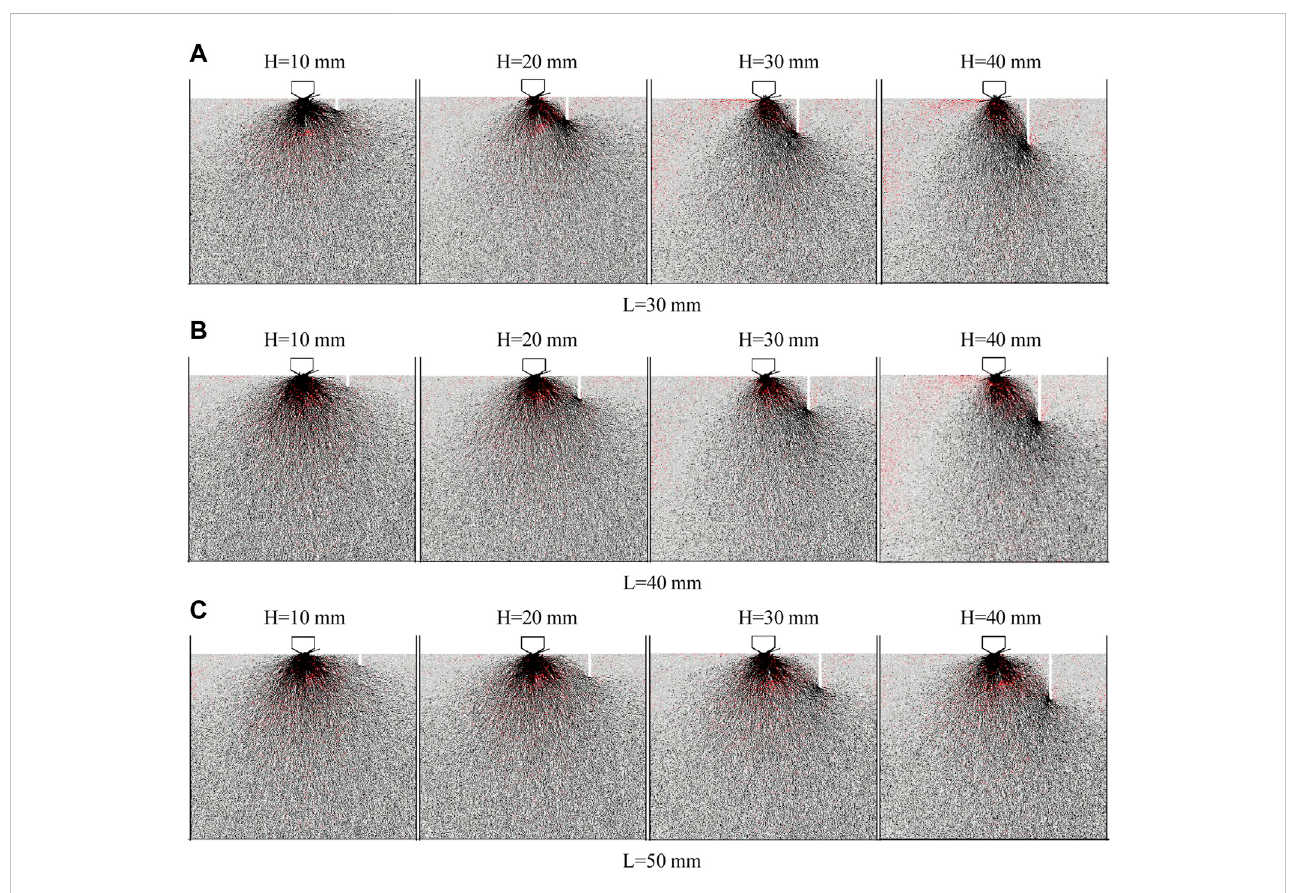
FIGURE 10 Distribution of force chain fi eld with different precutting slit parameters. (A) L = 30 mm, (B) L = 40 mm, (C) L = 50